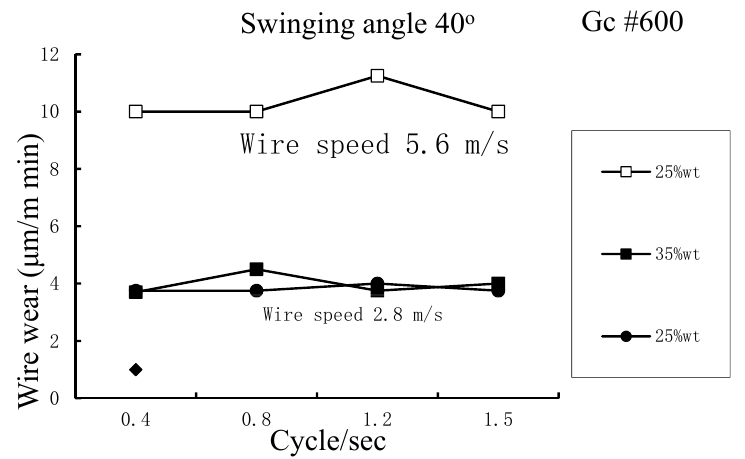
Figure 20. E ff ect of wire speed and swinging frequency on wire Figure 20. Effect of wire speed and swinging frequency on wire wear. Figure 20. Effect of wire speed and swinging frequency on wire wear. Figure 20. Effect of wire speed and swinging frequency on wire wear.